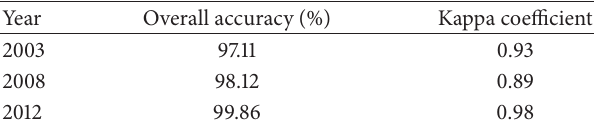
Table 2: Assessment of satellite images